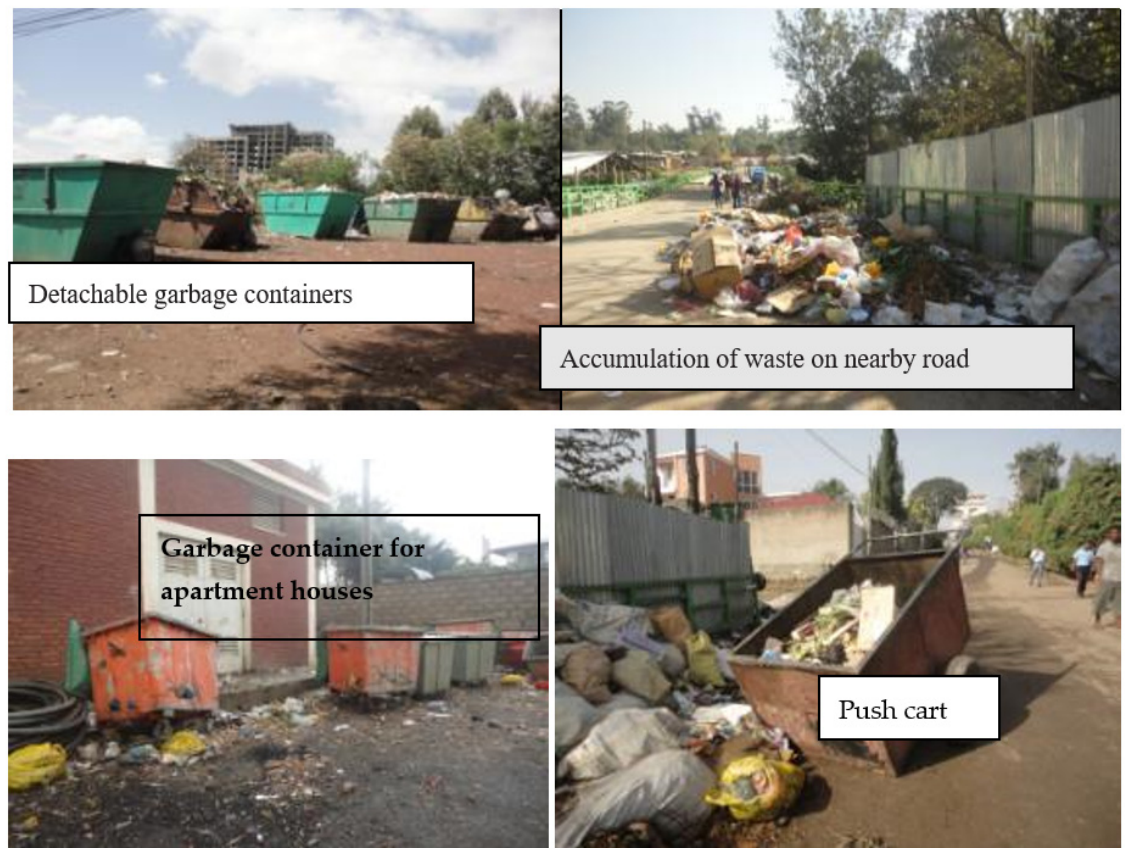
Figure 5. Primary collection and accumulation from households and small commercial centers.